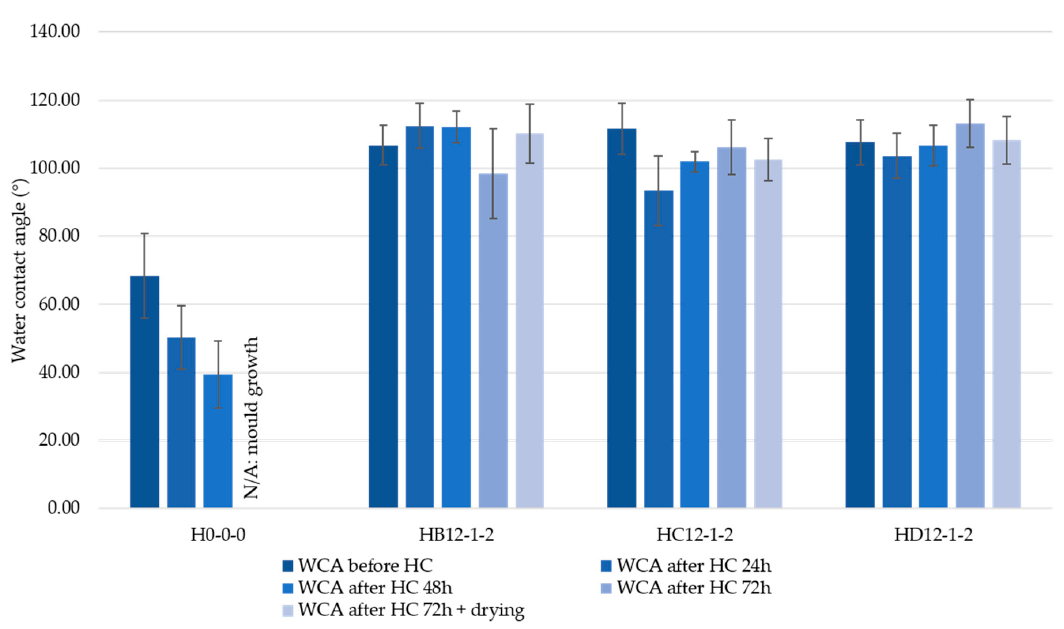
Figure 7. Humidity chamber test (35 °C and 90% RH). The measurements were executed every 24 h until signs of mould growth were visible on at least one sample, and after drying at room temperature for five days. Only very little variation of WCA during the experiment for the coated samples was shown, and mould was prevented from developing.